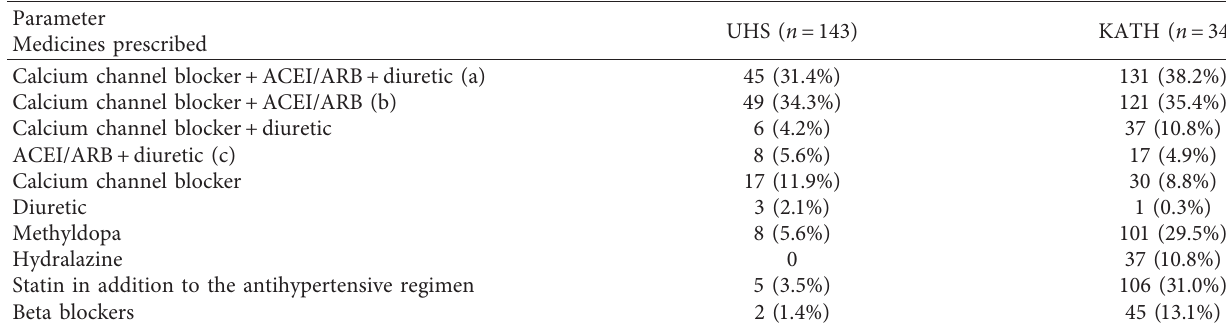
Table 4: Antihypertensive medications prescribed for